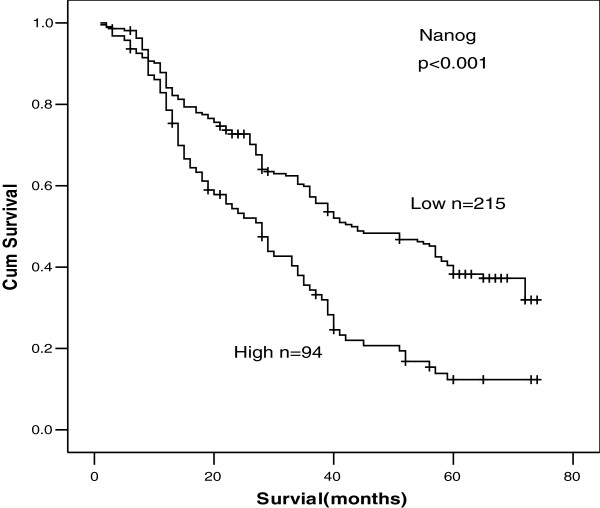
The Kaplan-Meier analysis of survival rate of patients according to status of Nanog expression.